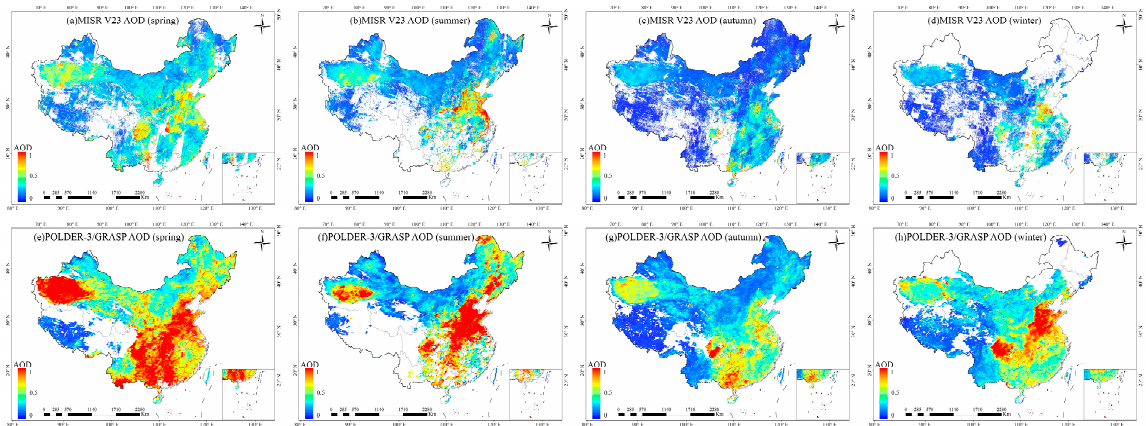
Figure 8. Distributions of seasonal mean AOD in 2012 from MISR V23 at 558 nm (( a ) spring; ( b ) summer; ( c ) autumn; ( d ) winter) and POLDER-3/GRASP at 565 nm (( e ) spring; ( f ) summer; ( g ) autumn; ( h ) winter).